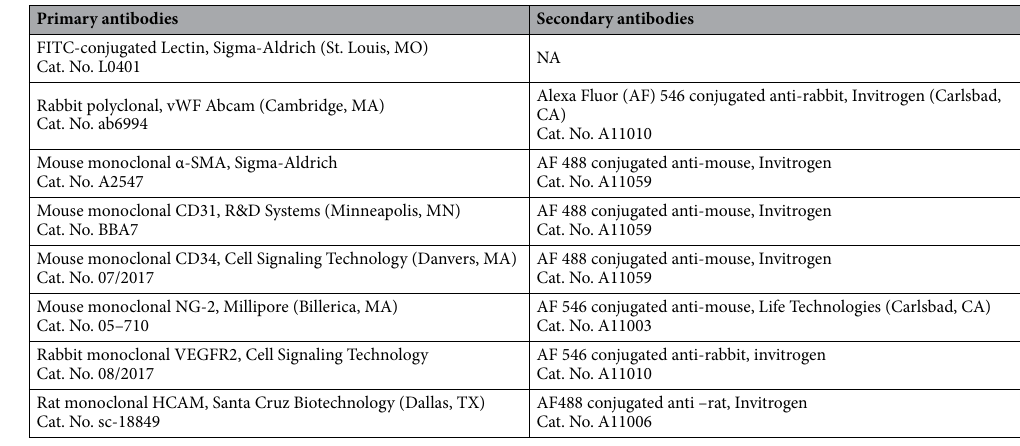
Table 3. List of antibodies and their distribution